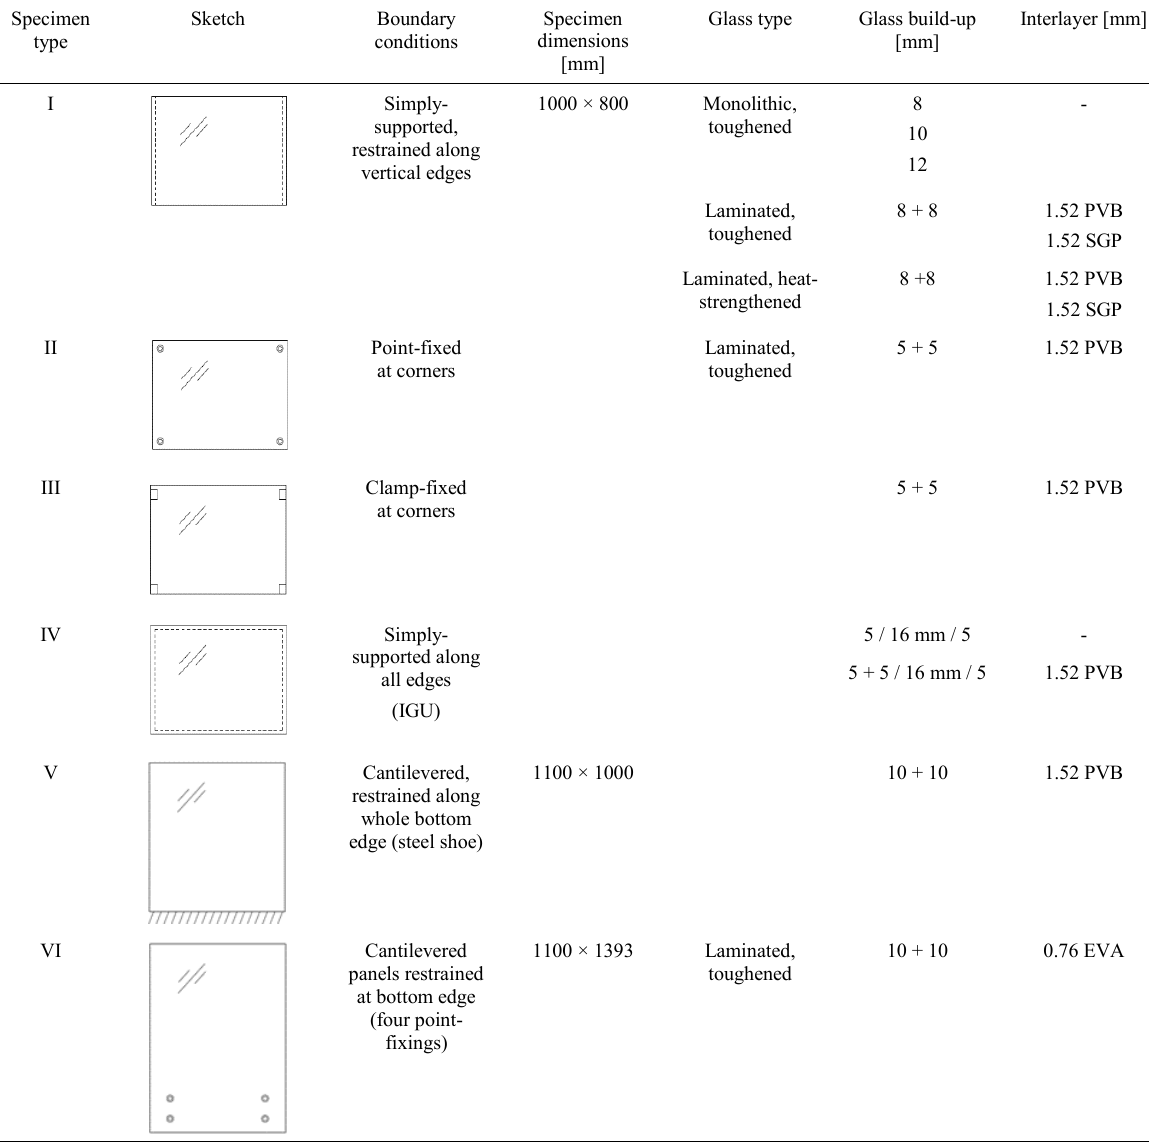
Table 2: Overview of tested